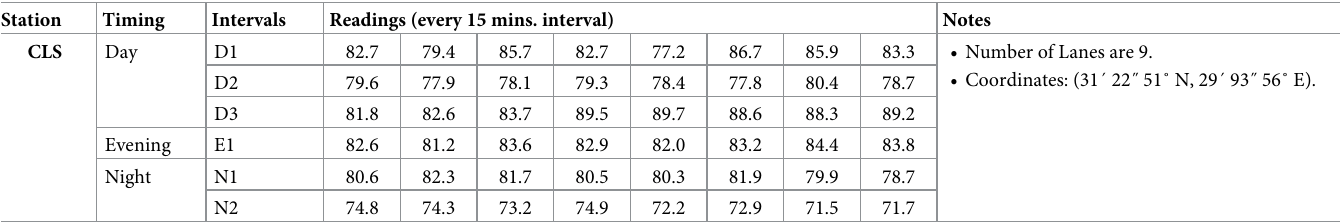
Table 9. The data sheet for Cleopatra Station (CLS) showing the noise level readings that were taken at the station on the selected intervals of the working day. Station Timing Intervals Readings (every 15 mins.